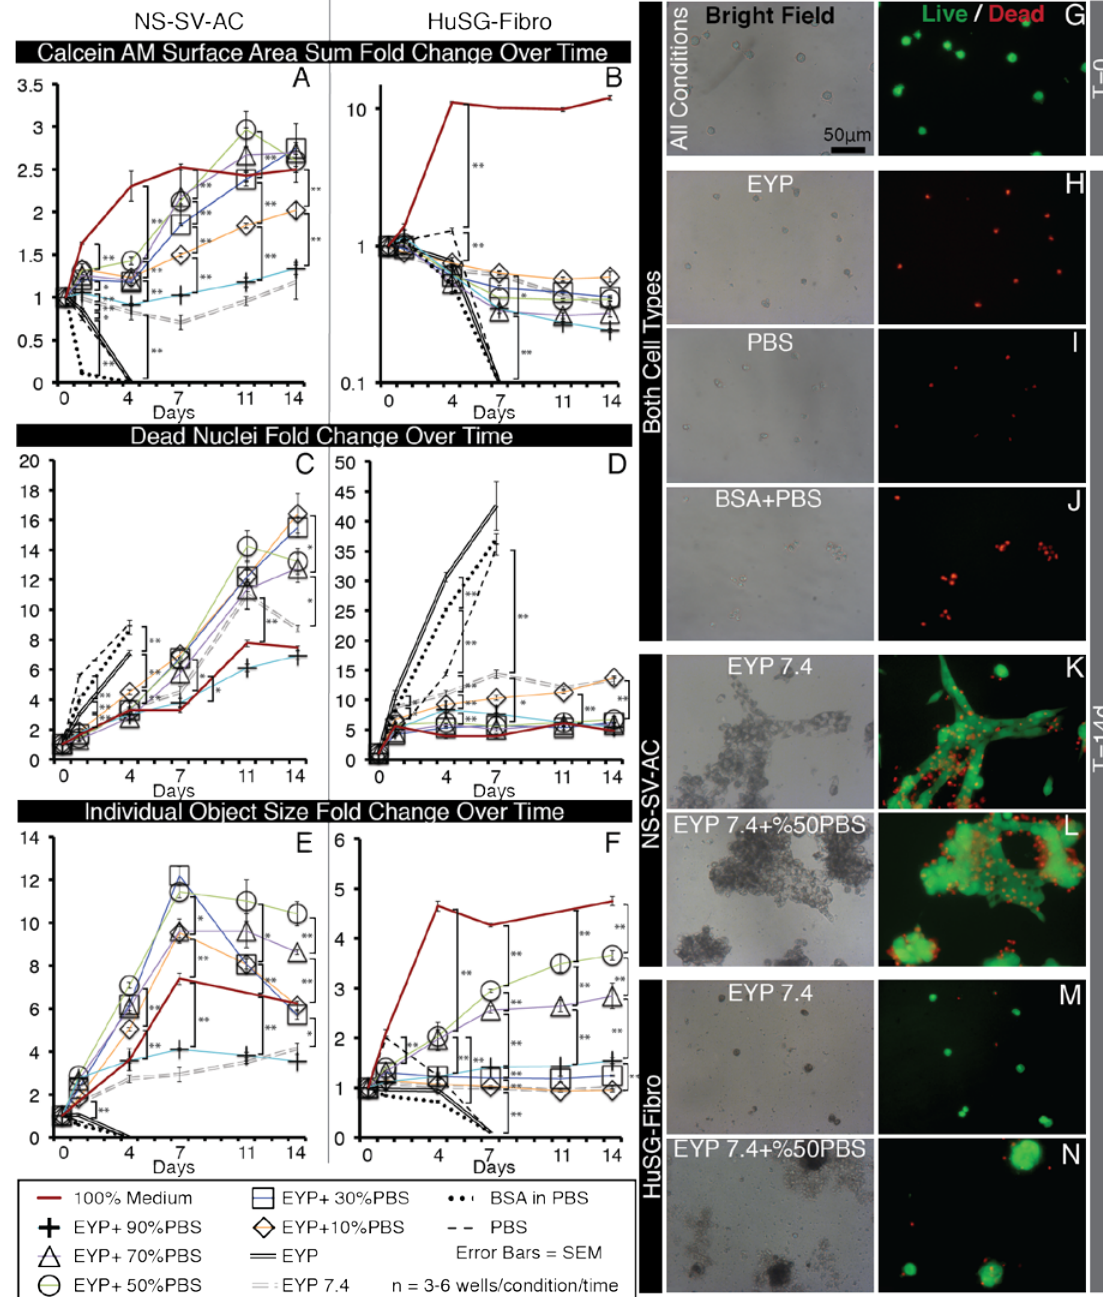
Figure 4. Selected Bright Field and Fluorescent Images of NS-SV-AC and HuSG-Fibro Cells in EYP + NaOH (EYP7.4) Cultures with Different Concentrations of PBS, Stained with Live/Dead and Images Quantified by Image Analysis. ( A – F ) Whole well images captured with 2X objective were subjected to computer analysis algorithms to detect Calcein Am (Live) areas (in μm 2 ) and EthD (Dead) nuclei counts then normalized to T = 0. ( A , B ) In sums, totals of green pixels were added in each well. ( C , D ) For dead cells, individual dead nuclei were counted in each well. ( E , F ) With objects, pixel values for either individual cells or clusters of cells were considered an object and means of their area were calculated per well. For statistical analysis we used one-way ANOVA followed by Tukey’s Post-Hoc test with p-values = * <0.05, ** < 0.01. ( G – N ) Images captured with 20X objectives from inside wells of a 96 well plate shown representative morphology of Live Dead stained NS-SV-AC or HuSG-Fibro cells in various conditions. More images are found in Figure A5.